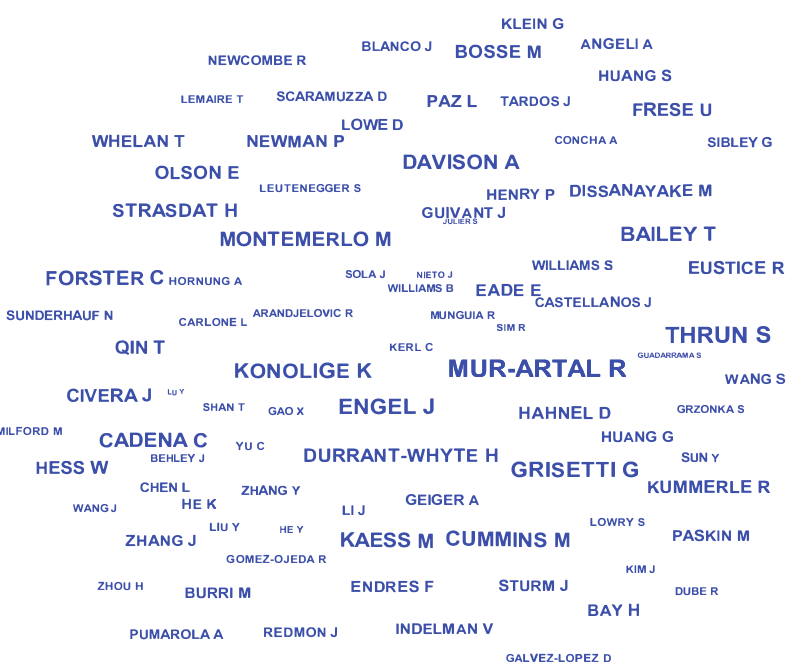
Figure 7. A distinguished scholar in the field of visual SLAM.